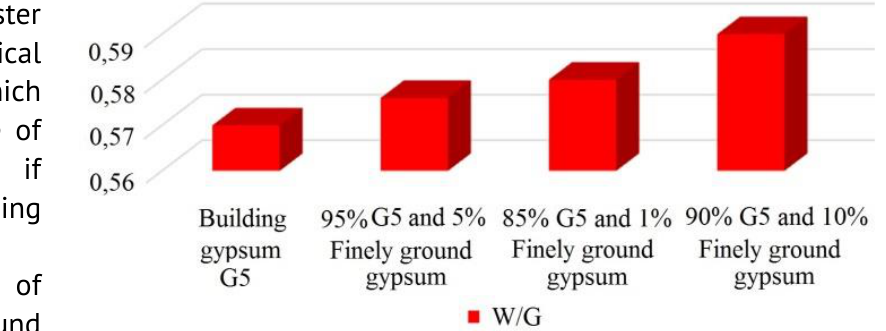
Figure 8. Diagram of impact of granulometric composition on water-to-gypsum ratio.